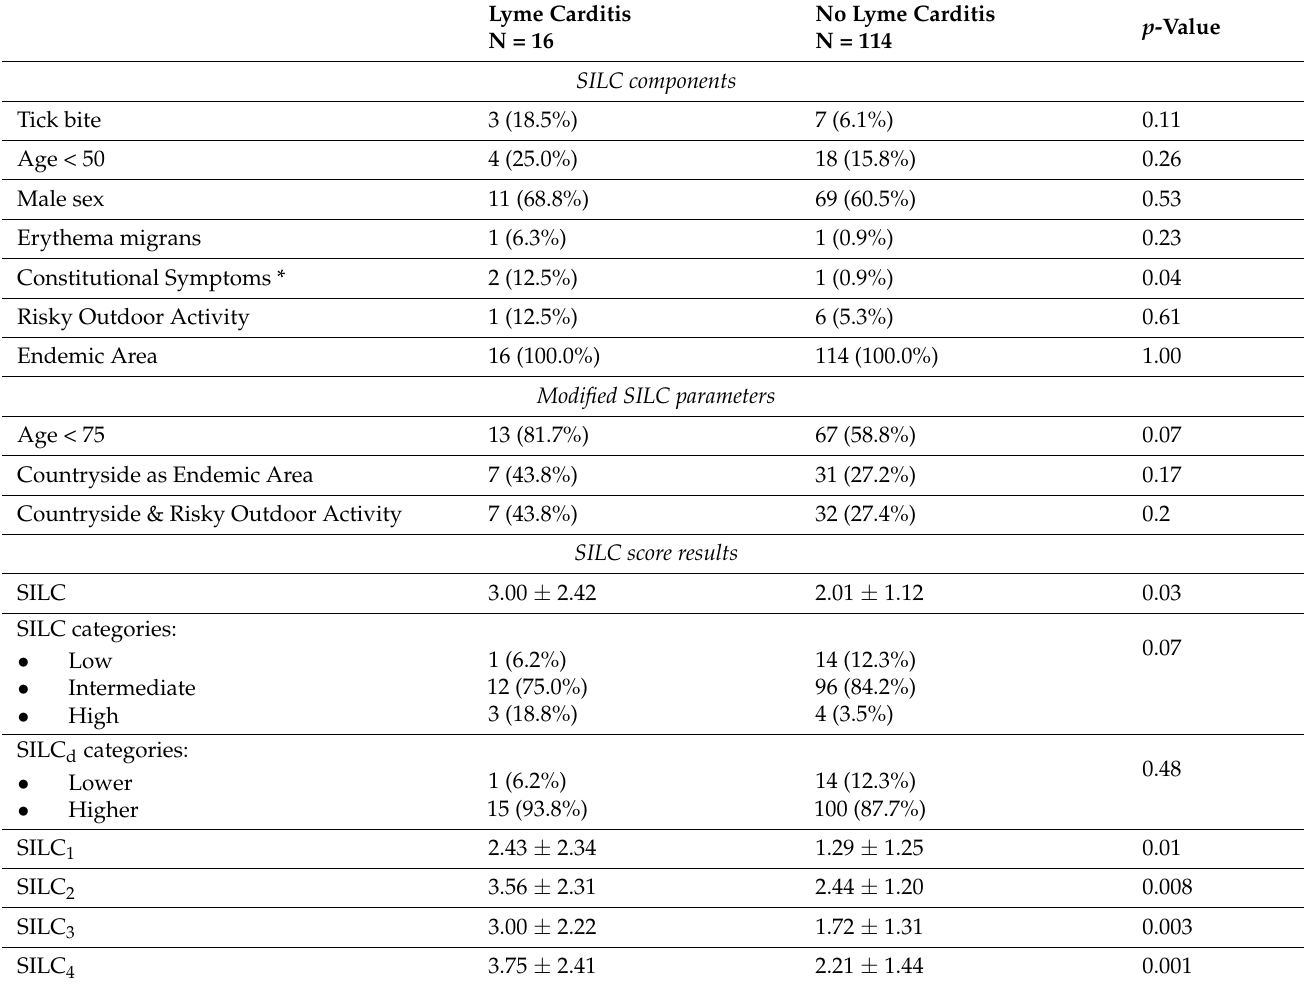
Table 4. Parameters connected with Lyme carditis (SILC